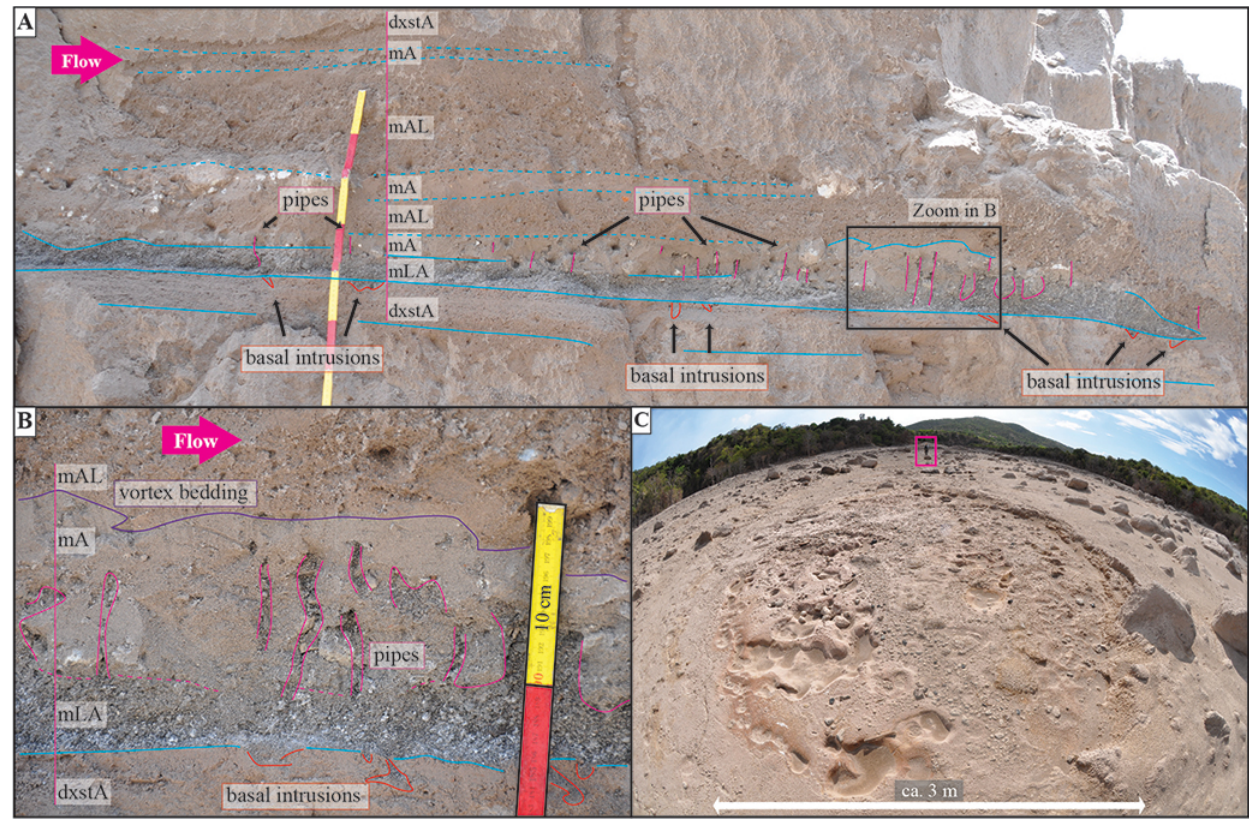
Figure 1. SSD from the 2010 dome collapse PDC deposits at Soufrière Hills in the Belham valley. (a) Degassing pipes occur in a massive ash (mA) layer, and seem to emanate from the underlying massive lapilli and ash layer (mLA). The base of the mLA layer also exhibits basal intrusions of small pipes, and attached potatoids in the underlying diffusely cross-stratified ash bed sets (dxstA). (b) Zoom in SSD structures. The upper contact is uneven with a vortex and undulating form. (c) Large-scale, circular depression, ca. 10cm in throw. Note also smaller-scale structures within the main